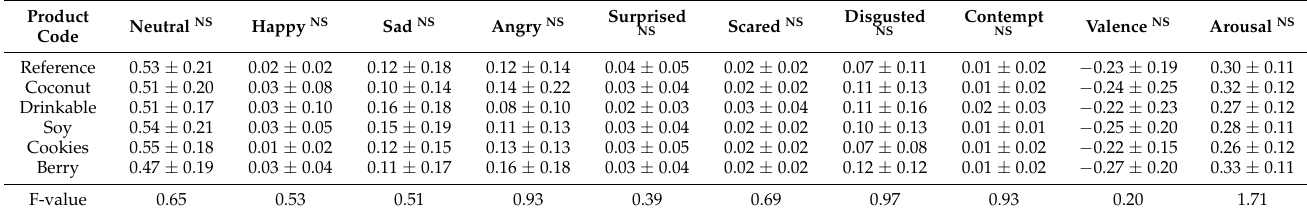
Table 4. Mean values for the biometric emotions for Western consumers.